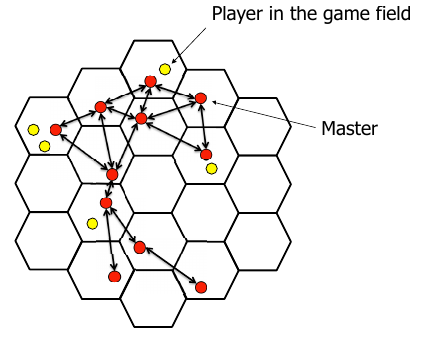
Fig. 4. Communication with masters of adjacent